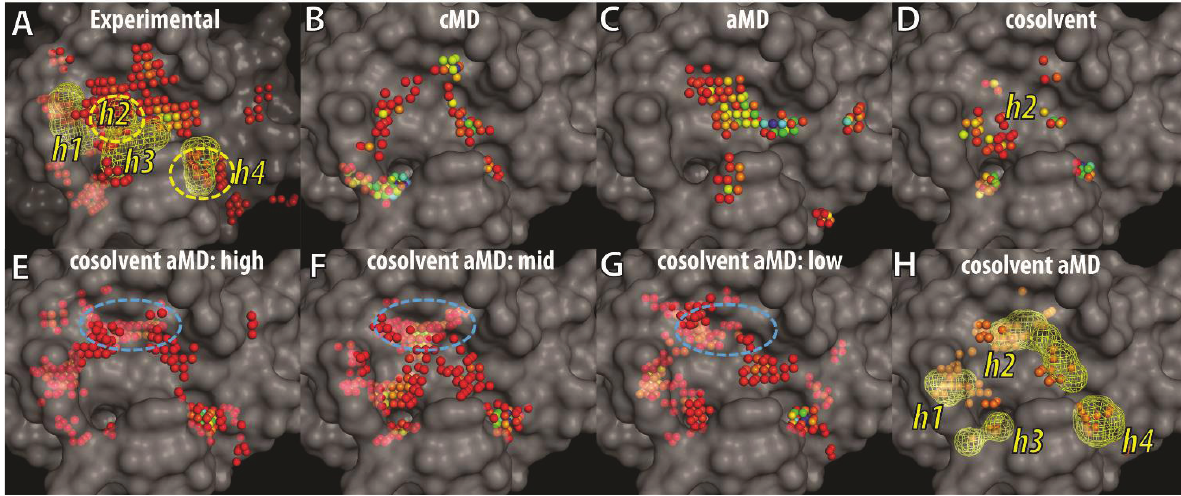
Figure 6. Grid-based hotspot mapping of ( A ) 72 experimental Bcl-xL structures and ( B ) cMD; ( C ) aMD; ( D ) cosolvent MD; or ( E – H ) cosolvent aMD simulations, starting